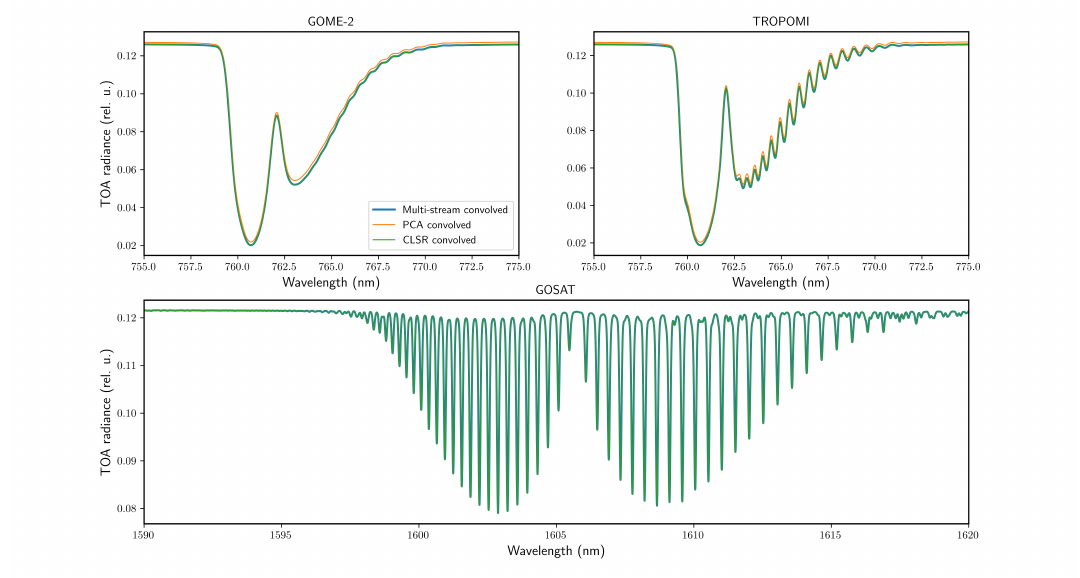
Figure 10. Convolved spectra for the multi-stream model and the two acceleration methods for the ‘Cloud 1’ scenario using PCA and CLSR methods for the sensors GOME-2, TROPOMI and GOSAT. For GOME-2 and TROPOMI the O 2 A-band spectra are convolved, while for GOSAT the CO 2 spectra are